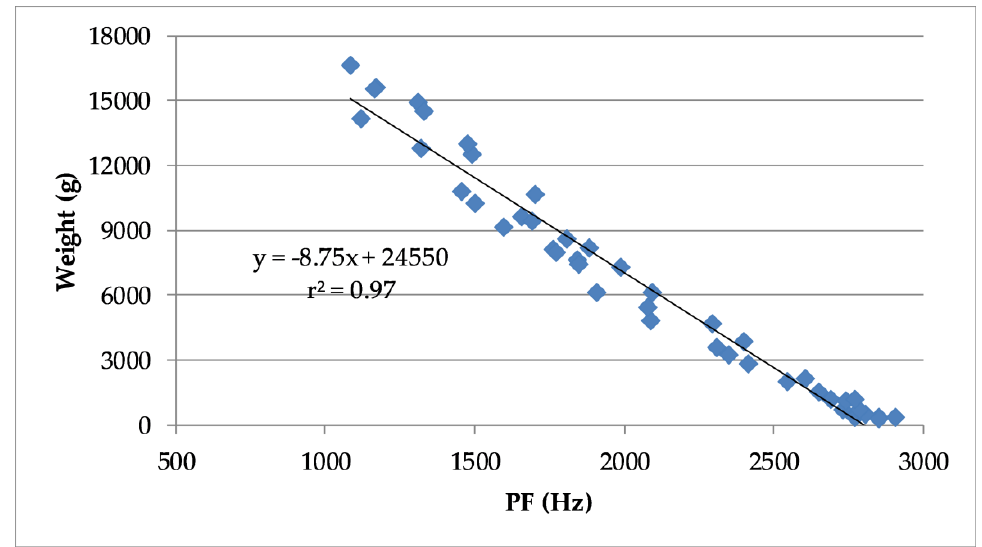
Figure 9. Linear regression and coefficient of determination between turkey weight and the peak frequency (PF) turkey vocalizations based on pooled data from all trails.